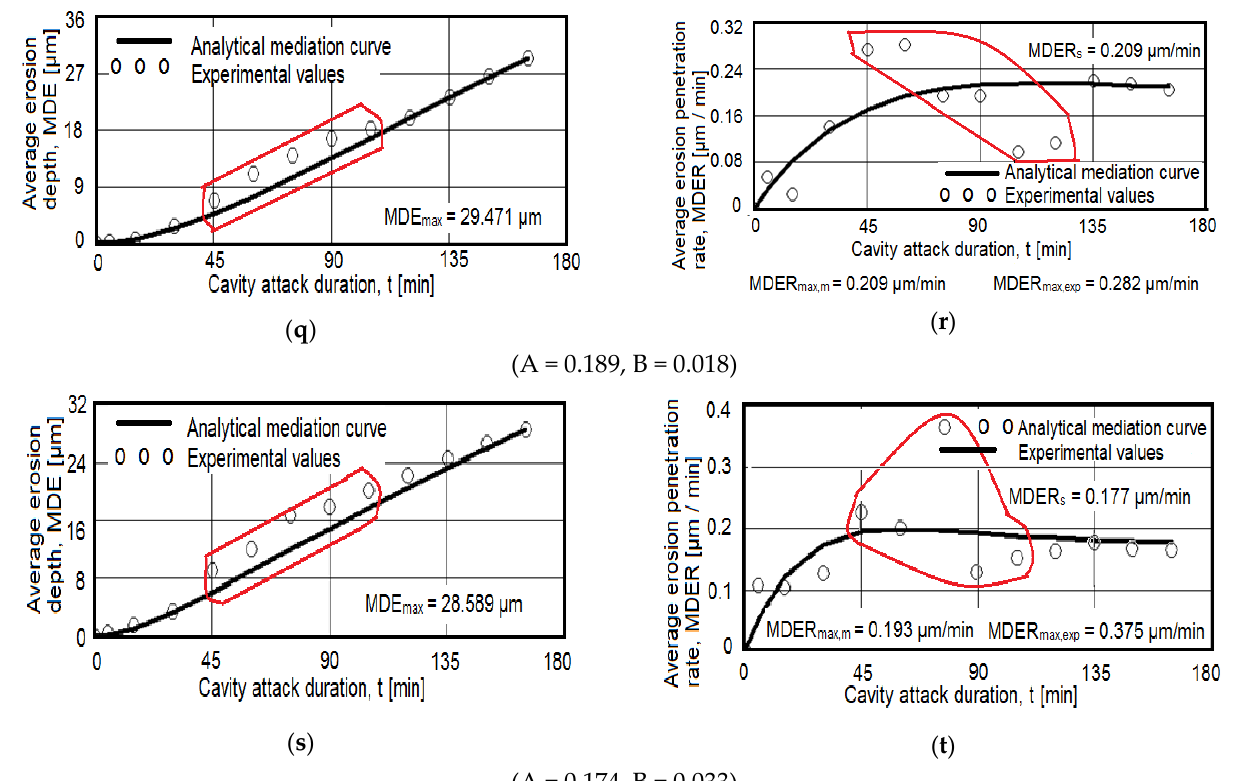
(A = 0.174, B = 0.033) Figure 9. Average erosion depth ( a , c , e – i , k , m , o , q , s ) and average erosion rate ( b , d , f , h , i , l , n , s , t ) versus cavitation exposure time of the experimental samples of aluminum type 5083: ( a , b ) gauge sample, ( c – h ) after 350 ◦ C/100 min/air + 180 ◦ C, ( i – n ) after 450 ◦ C/100 min/air + 140 ◦ C, ( o – t ) after 450 ◦ C/100 min/air + 180 ◦ C, ( c , d , i , j , o , p ) 1 h maintainig, ( e , f , k , l , q , r ) 12 h maintaining ( g , h , m , n , s , t ) 24 h maintaining 200 × , ( c ) 500 × , ( d ) 2000 × . Table 5. Parameters of erosion–cavitation process of the experimental 5083 aluminum samples.